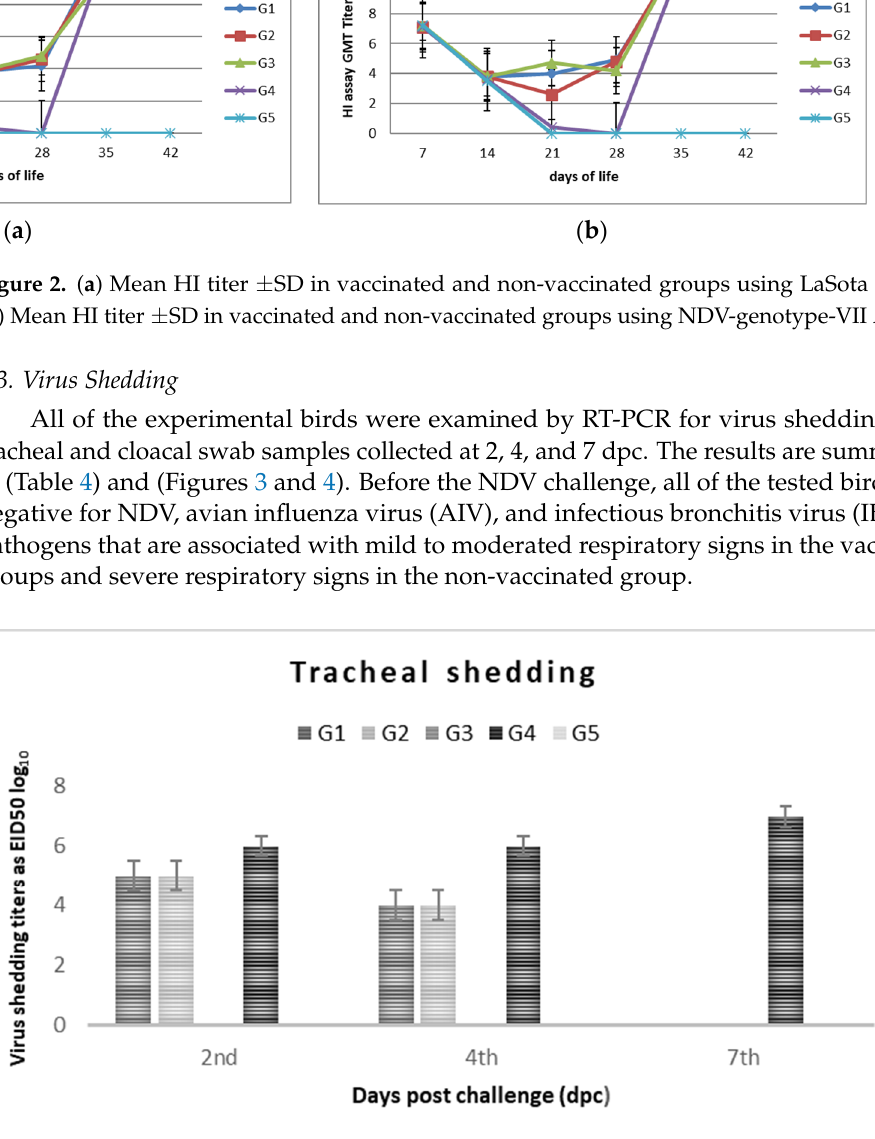
Figure 4. Cloacal shedding titers log 10 EID 50 /1 mL (±SD) in vaccinated and non-vaccinated broiler chickens at dpc.